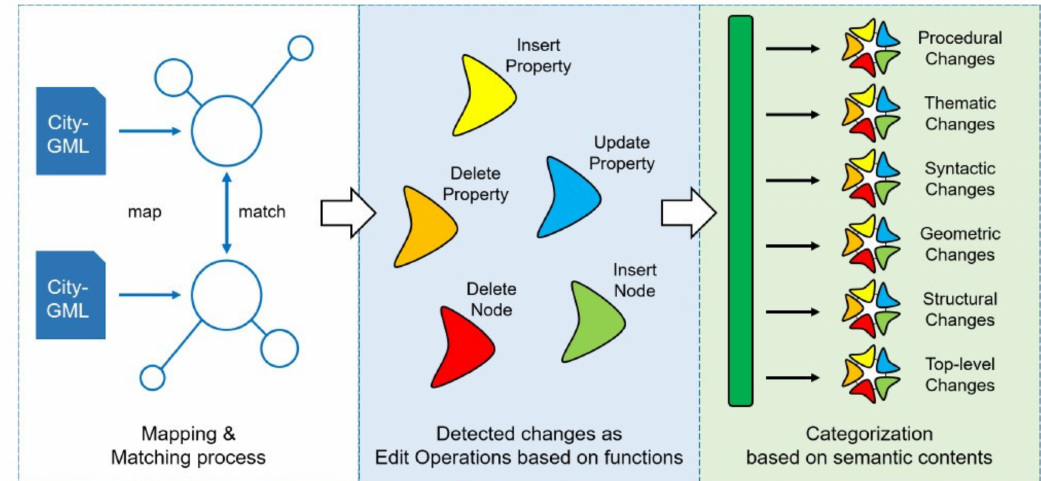
Figure 2. CityGML datasets are mapped to the graph database and graphs are matched. Different edit operations are detected, and changes are categorized based on their semantic content (from Nguyen and Kolbe